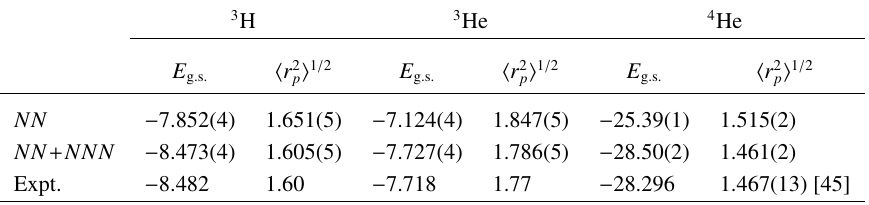
Table 1. Calculated 3 H, 3 He and 4 He g.s. energies (in MeV) and point-proton radii (in fm), obtained using the N 3 LO NN potential [44] with and without the local N 2 LO NNN interaction [42] with c D = − 0 . 2 and c E = − 0 . 205, compared to experiment. 3 H 3